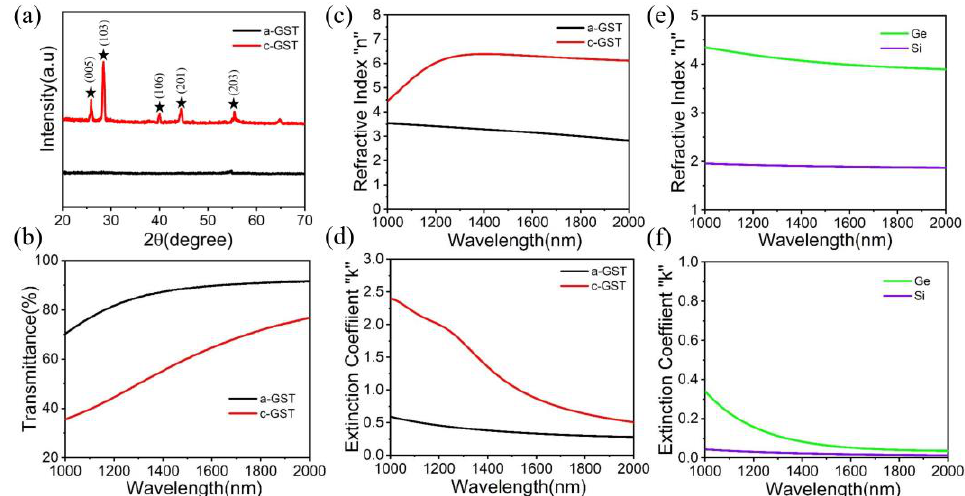
Figure 2. ( a ) XRD data of a-GST and c-GST films, where the star symbol corresponds to the peak position. ( b ) The transmittance of a-GST and c-GST films. ( c , d ) The real and imaginary parts of the refractive index of a-GST and c-GST films. ( e , f ) The real and imaginary parts of the refractive index of Ge and Si films.